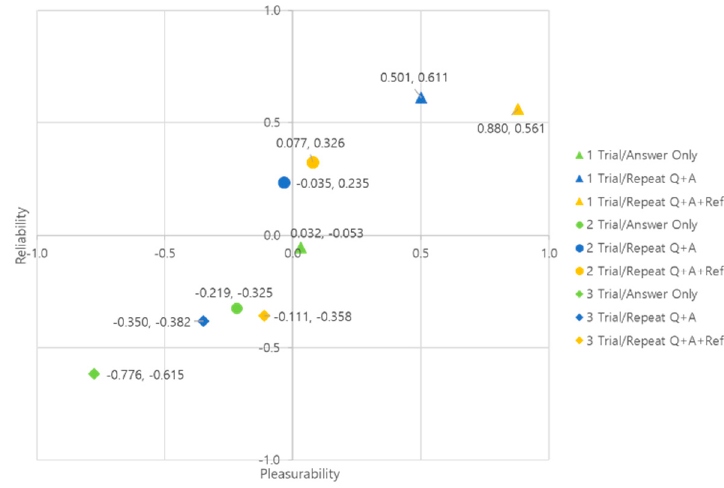
Figure 5. Classification map of emotional satisfaction.